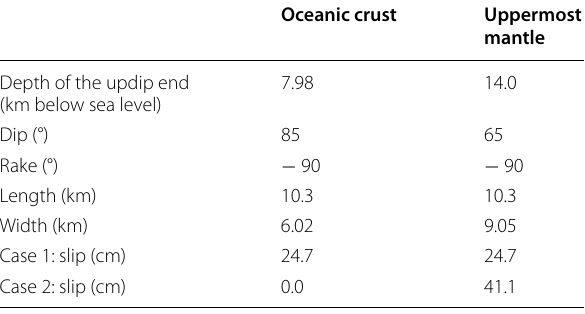
Table 1 Fault parameters of the September 20, 2017 earthquake Oceanic crust Uppermost mantle